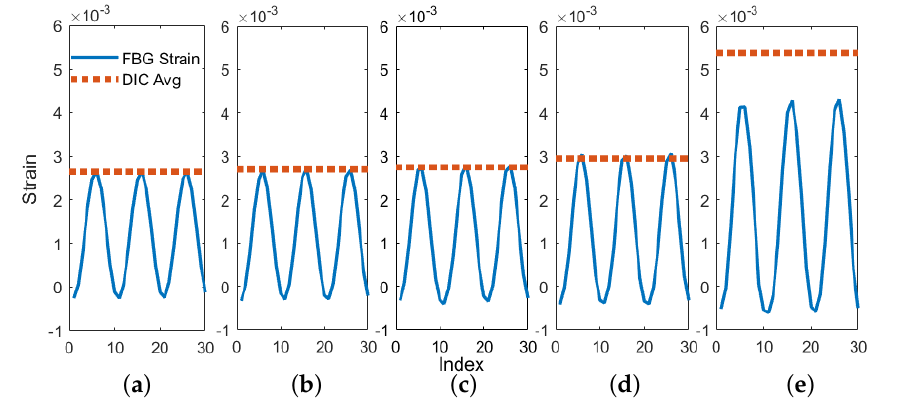
Figure 11. Comparison of the FBG strain signal and the average peak strain from DIC in the region of